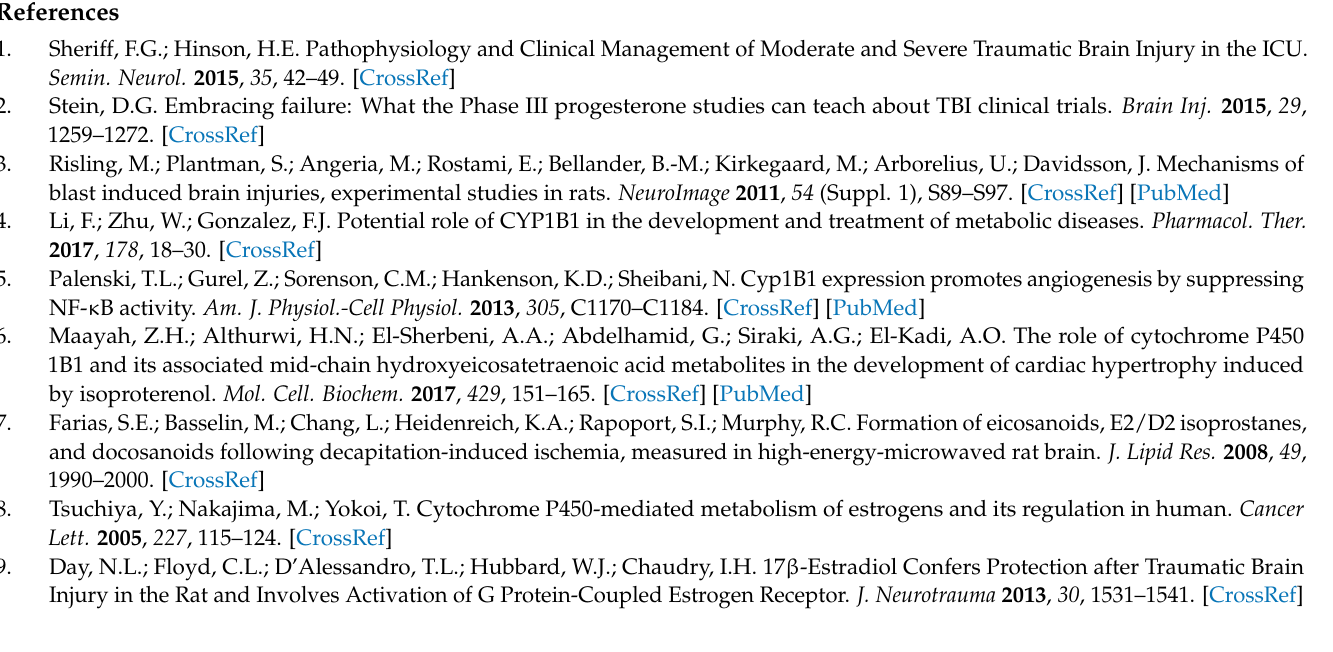
Abbreviations: CYP1A1: Cytochrome P450 1A1, CYP1A2: Cytochrome P450 1A2, CYP1B1: Cytochrome P450 1B1, CYP2A1: Cytochrome P450 2A1, CYP2A2: Cytochrome P450 2E1, CPR: Cytochrome P450 reductase, pTBI: Penetrating traumatic brain